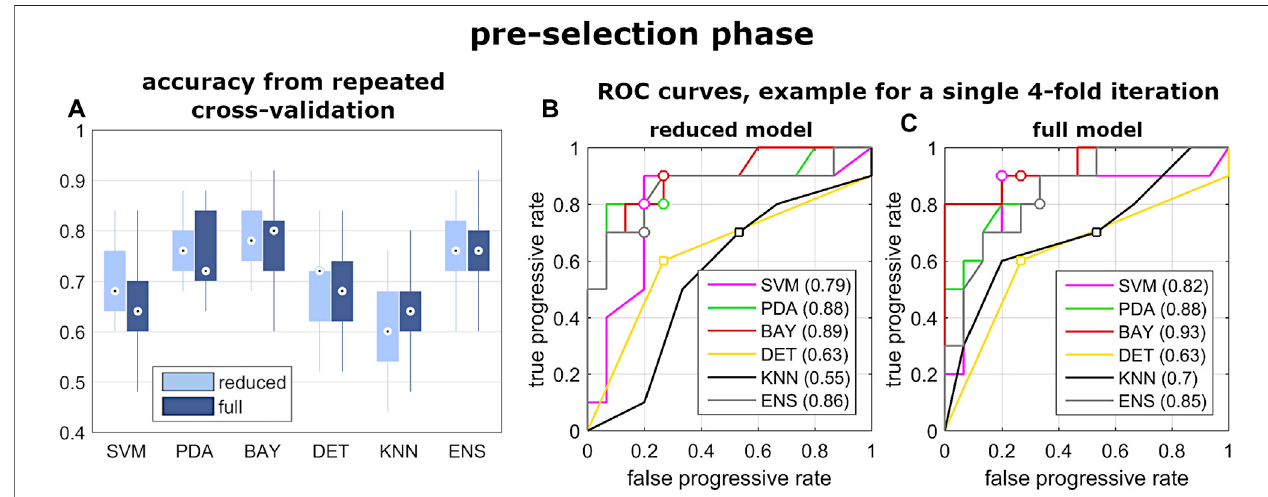
FIGURE 5 | Results from the pre-selection phase of step iii). Box and whiskers plot reporting the distribution of the accuracy values obtained by the evaluated classi fi cation algorithm (A) ; and example of ROC curves calculated by exploiting one selection of training- and test-set of the 4-folds iteration, for reduced and full model (B,C) .